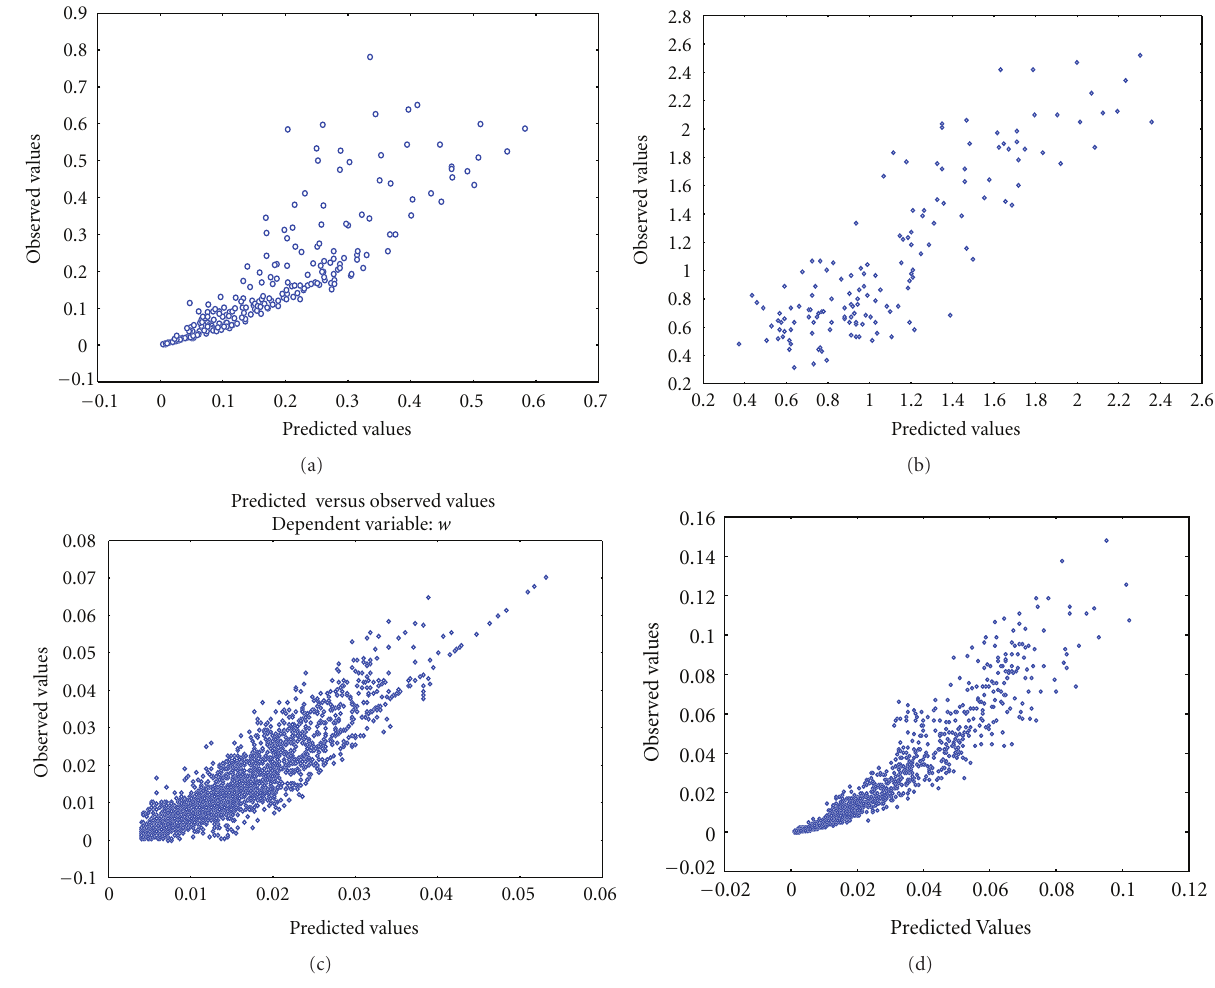
Figure 2: Corresponding observed versus predicted values for the fitting of the isometric model for each site. (a) Mesocosm, (b) Jindong Bay, (c) Punta Banda estuary, and (d) San Quintin